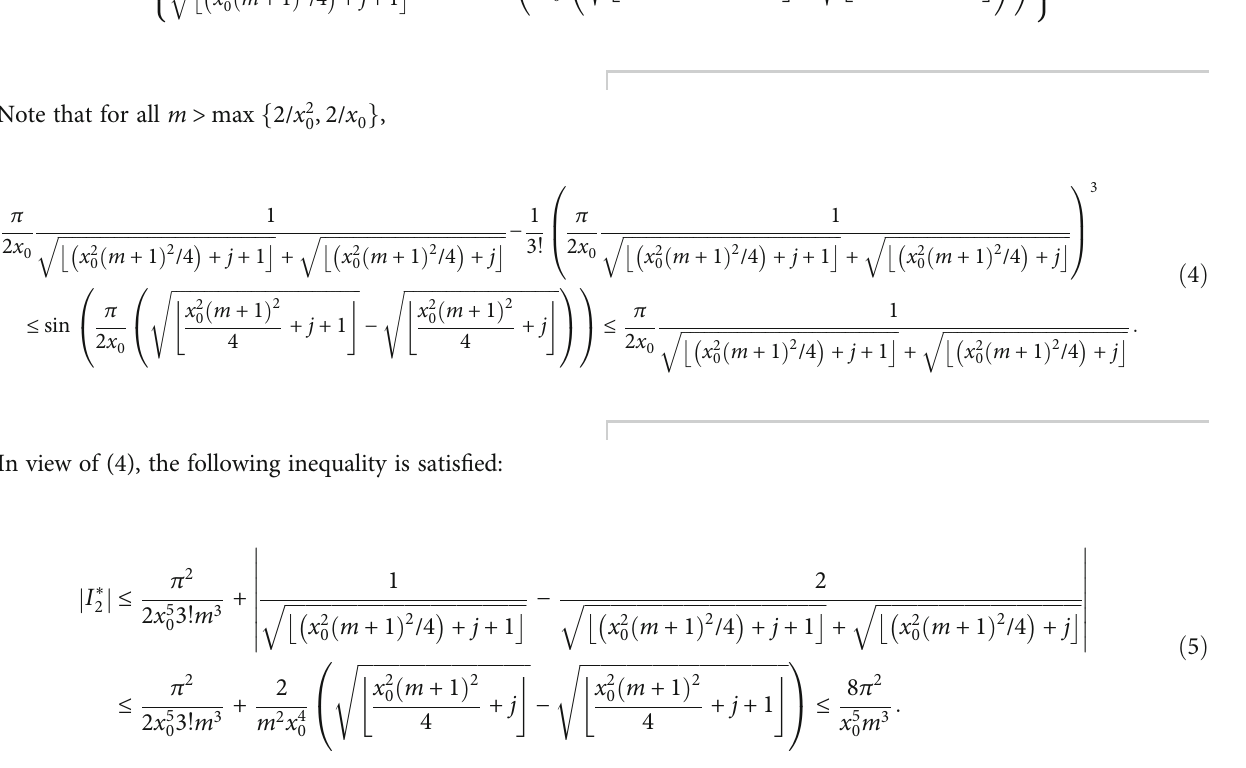
ffiffiffiffiffiffiffiffiffiffiffiffiffiffiffiffiffiffiffiffiffiffiffiffiffiffiffiffiffiffiffiffiffi x 2 m + 1 ð 0